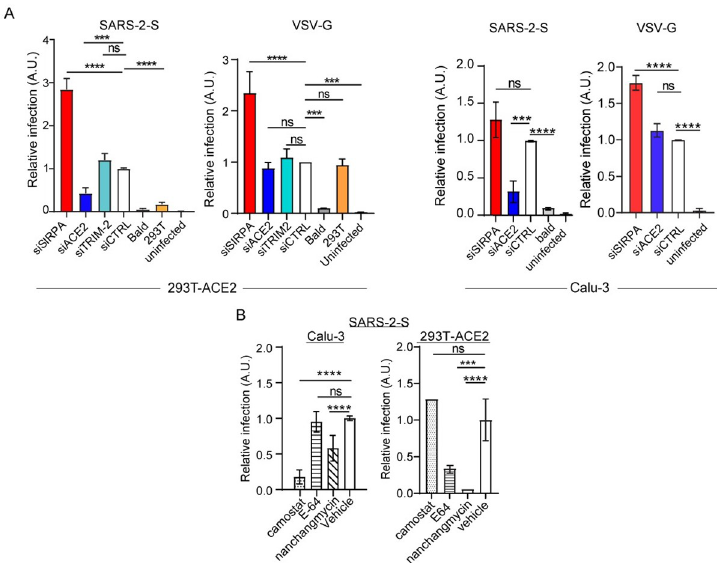
Fig 2. SIRPA inhibits endosomal but not cell surface entry of SARS-CoV-2. A) 293T-ACE2 or Calu-3 cells were transfected with the indicated siRNAs and then infected with SARS-2-S or VSV G pseudoviruses. Luciferase assays were performed at 48 hpi. B) Calu-3 or 293T-ACE2 cells were treated with the indicated drugs (camostat inhibits TMPRSS2; E-64D inhibits endosomal Cat B/L; nanchangmycin is an endocytosis inhibitor) infected with SARS-2-S and VSV G pseudoviruses. Shown is the average ± SD of 3–6 independent experiments. One-way ANOVA was used to determine significance. � , P � 0.02; �� , P � 0.001; ��� , P � 0.0003; ���� , P � 0.0001.